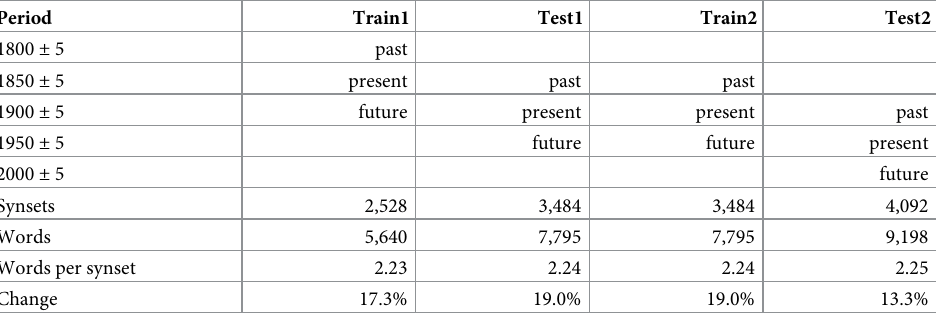
Table 1. Time periods for the training and testing sets, given a fifty-year cycle of eleven-year samples. The average synset contains 2.23 to 2.25 words. Period Train1 Test1 Train2 Test2